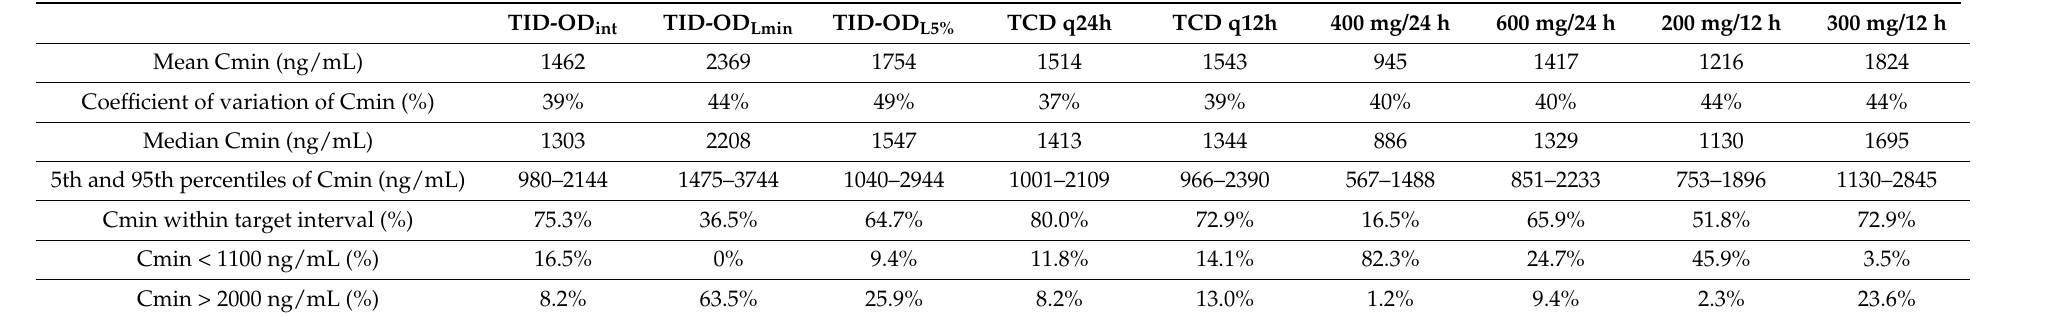
Table 4. Predicted imatinib C min and attainment of target interval (1100–2000 ng/mL) in 85 patients with GIST.